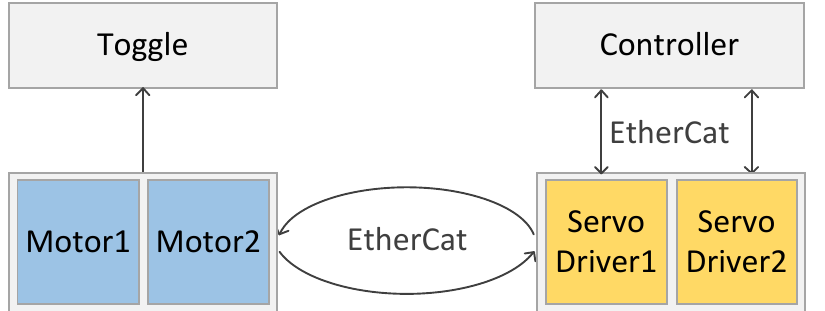
Figure 2. Control system of a toggle mechanism ( TM ), which consists of a controller, servo driver, motor, and TM . The controller embedded algorithms and logic programs send commands to the servo driver to drive the motor. The motor is connected with the TM by a belt or lead